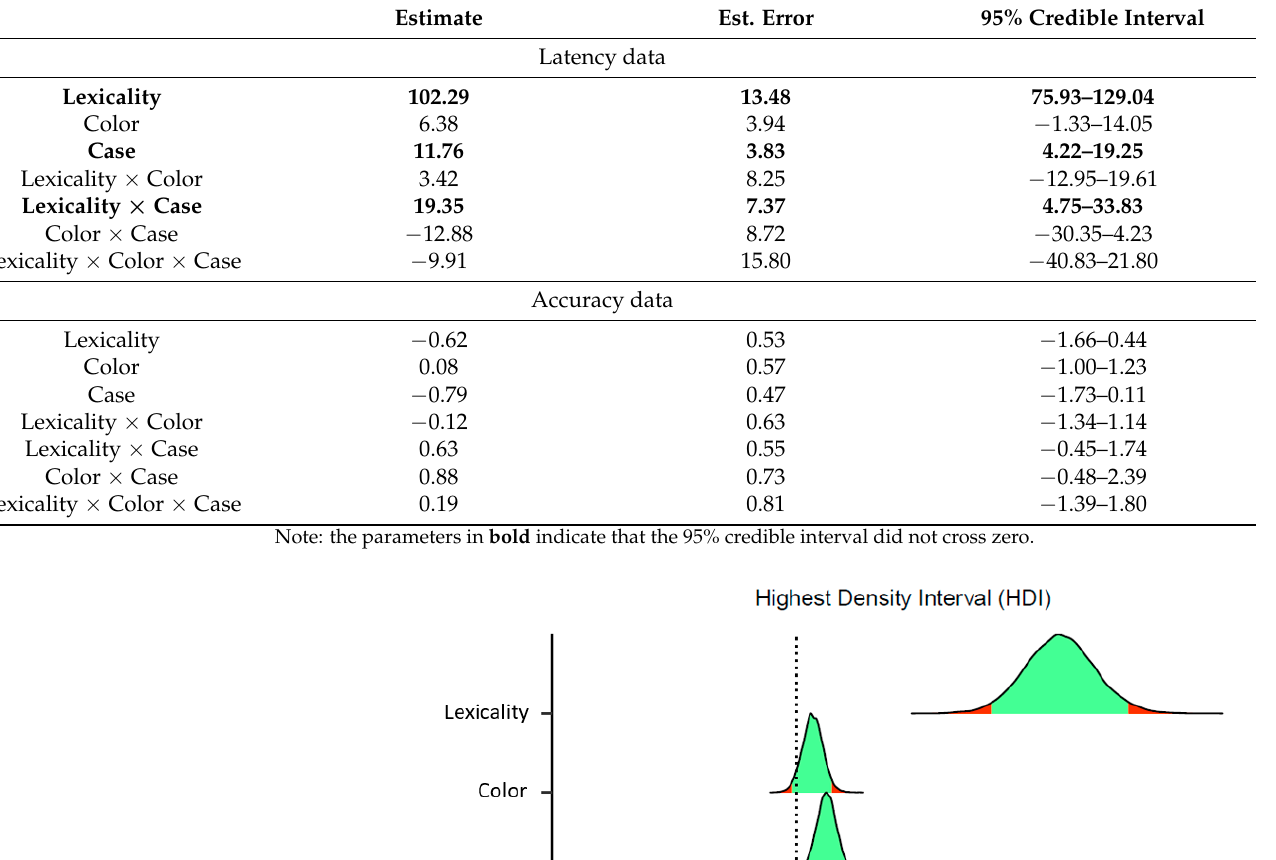
Table 2. Estimates from the Bayesian linear mixed-effects models for each of the critical conditions in the latency and accuracy analyses of the experiment.